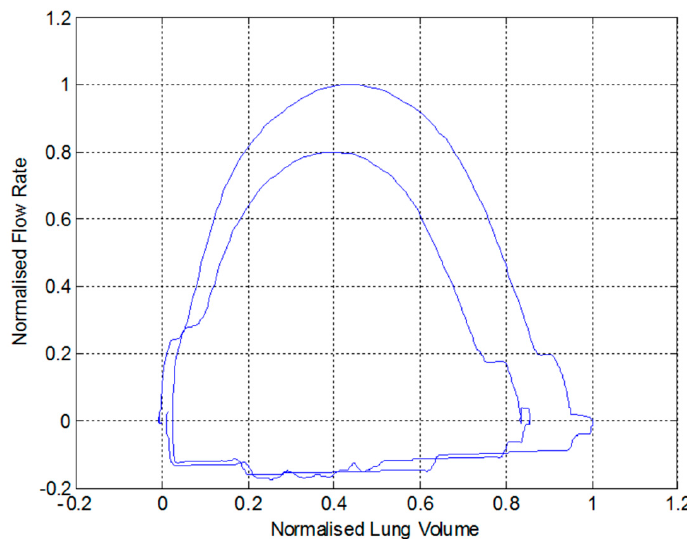
Figure 21. Normalised flow velocity and flow volume obtained from the recorded data produced by the low-cost sensor.